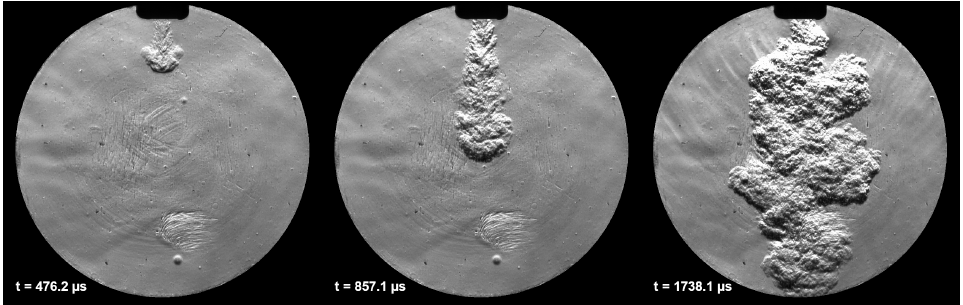
Figure 7. Spray penetration of the OsciJet nozzle ( Π =